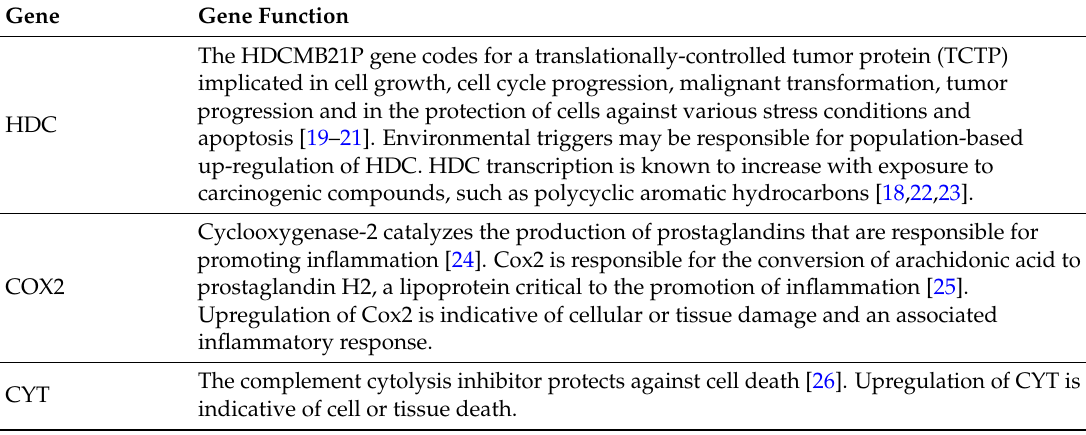
Table 1. Documented function of 10 genes identified in free-ranging sea otters sampled at the Alaska Peninsula, Katmai, Kodiak, Clam Lagoon, Prince William Sound 2006–2008, Prince William